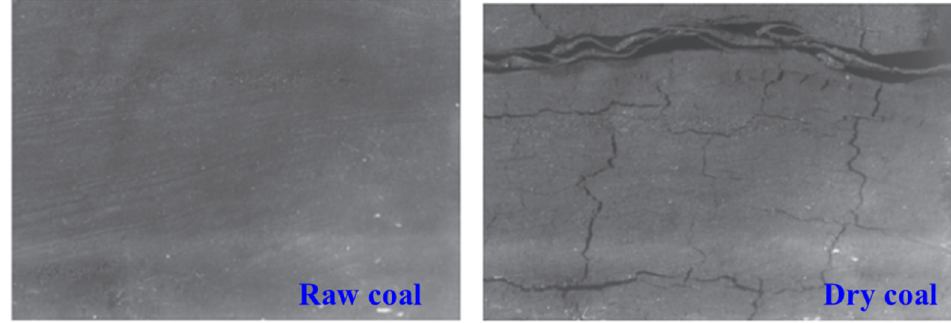
Figure 2. Microscopic images of coal during continuous heating (edited from [17]). 3. Current Status of Research Methods for Cavity Growth 3.1. Field Test 3.1.1. Direct Observation Method Currently, the field tests that can visually demonstrate the cavity growth process are basically located in the surface coal seams, and only a few field test results have been publicly reported. In 1976~1979, the Hoe Creek coal mine in the United States successively conducted three phases of UCG tests with a buried depth of about 40 m. Of these, the most valuable tracer studies came from the Hoe Creek II trial. In this test, it was observed that the lon- gitudinal growth rate of the cavity was faster than the horizontal growth rate, and the cavity was almost filled with a large amount of gravel [19]. In 1981~1982, the Centralia Coal Mine in the Tono Basin, Washington, USA success- fully conducted large-scale UCG tests, codenamed LBK-1~LBK-5, in five blocks. Among them, LBK-1 used CRIP technology for the first time to complete the injection of gasifica- tion agent and the production of syngas. The uniqueness of the LBK-1 test is that the UCG process is completed in the coal seam outcrop on the surface, where the generated cavity could be excavated [9]. The cavity excavated after gasification is shown in Figure 3; the cavity profile was generally similar to oval, and the aspect ratio of the cavity pro- file was between 1.3:1 and 1.7:1. Moreover, the boundaries of the void area, rubble area, and ash area in the cavity were evident from top to bottom. The void area was located at the upper part of the cavity, in the shape of an inverted bowl. The rubble area was in the middle area, consisting of dry coal, char, and crushed stone. At the same time, the ash area was confined to the cavity bottom [20,21].